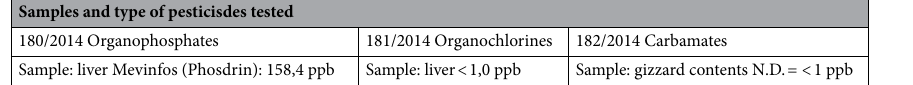
Samples and type of pesticisdes tested 180/2014